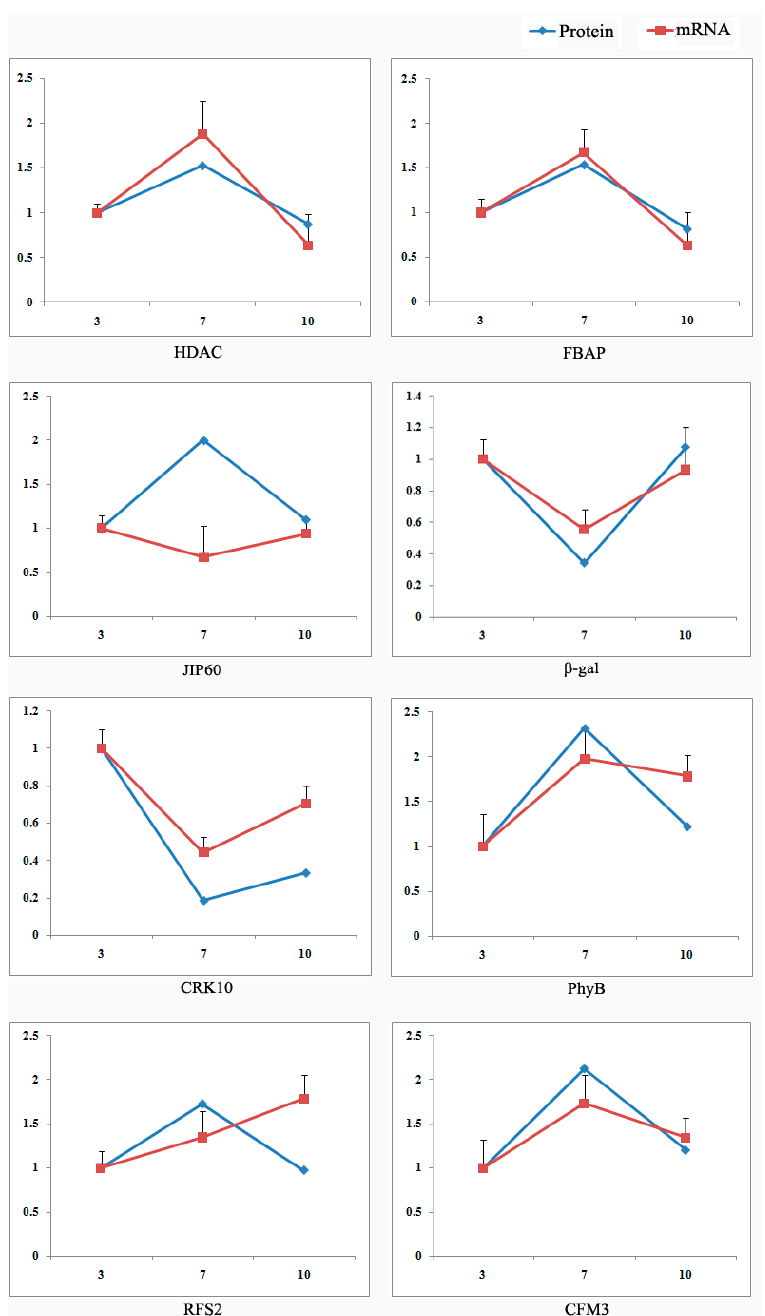
Figure 5. The expression trends in mRNA and protein levels of eight differentially expressed proteins. To assess the mRNA transcription profiles of the 24 functional proteins, eight genes of them were selected and verified by quantitative RT-PCR (qRT-PCR): the histone deacetylase complex subunit SAP18 ( HDAC ), fructose-bisphosphate aldolase ( FBAP ), 60 kDa jasmonate-induced protein-like ( JIP60 ), beta-galactosidase ( β -gal ), cysteine-rich receptor-like protein kinase 10 ( CRK10 ), phytochrome B isoform X1 ( PhyB ), galactinol—sucrose galactosyltransferase 2 isoform X1 ( RFS2 ), and CRM-domain containing factor CFM3 ( CFM3 ). There was a similar pattern between mRNA expression and protein synthesis for HDAC, FBAP, β -gal, CRK10, PhyB and CFM3; However, JIP60 and RFS2 showed different trend in these two profiles. The X axis represents the different days after flowering (DAF), while the Y axis indicates the relative expression level of protein and mRNA. The blue line represents the pattern of protein expression, and the red line indicates the pattern of mRNA expression.